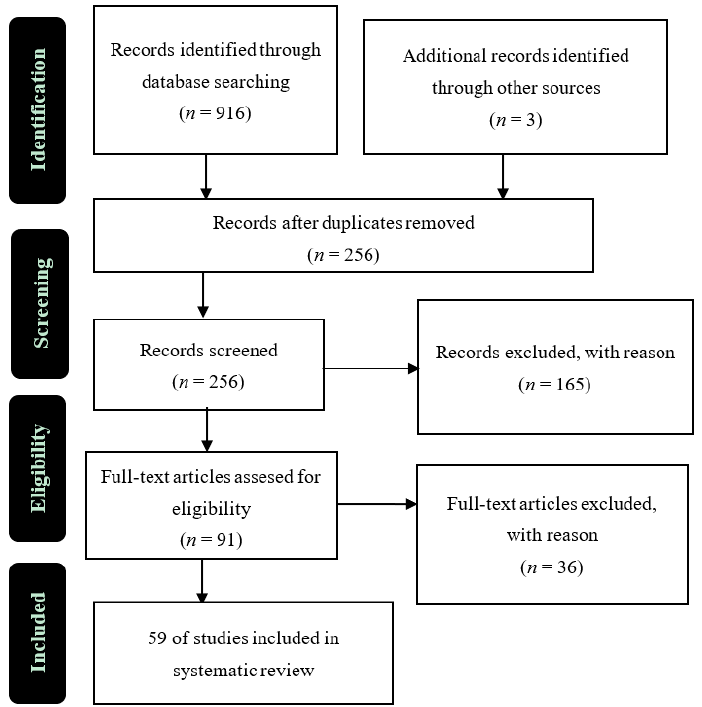
Figure 1. Summarized search method based on the PRISMA method.